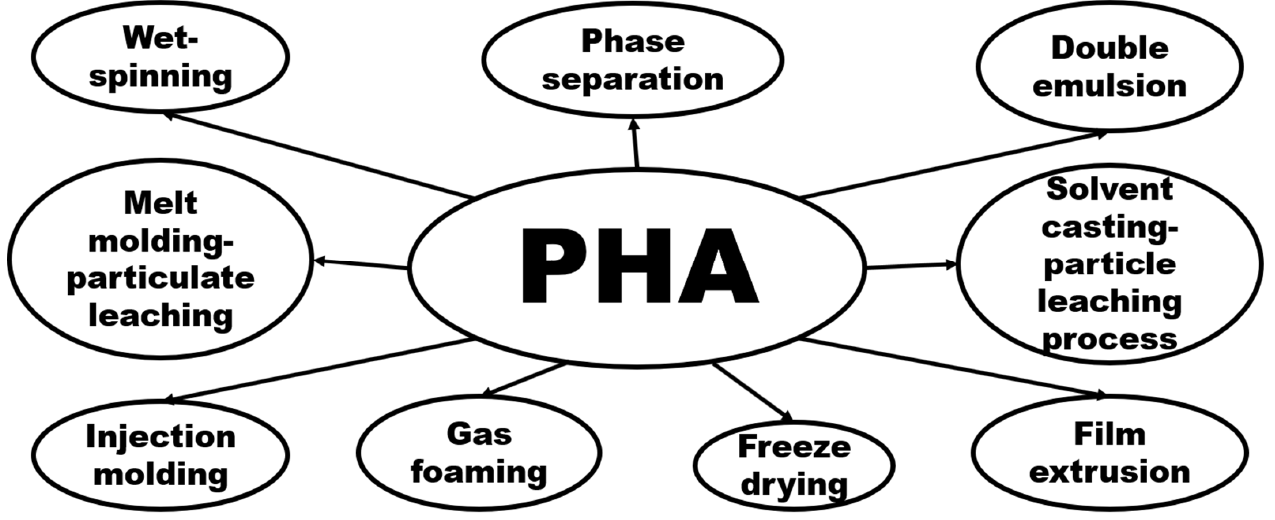
Figure 4. A scheme for PHA production specifically for biomedical applications. On Figure 5 the molecular structures of commercially available at the industrial scale PHAs [61] is demonstrated.